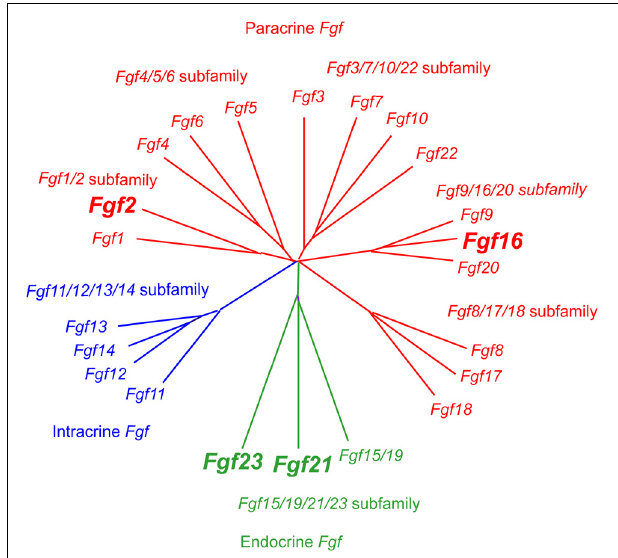
FIGURE 1 | Evolutionary relationships within the human/mouse Fgf gene family by phylogenetic analysis. Phylogenetic analysis suggests that twenty-two Fgf genes can be arranged into seven subfamilies containing two to four members each. Branch lengths are proportional to the evolutionary distance between each gene (Itoh and Ornitz, 2011).